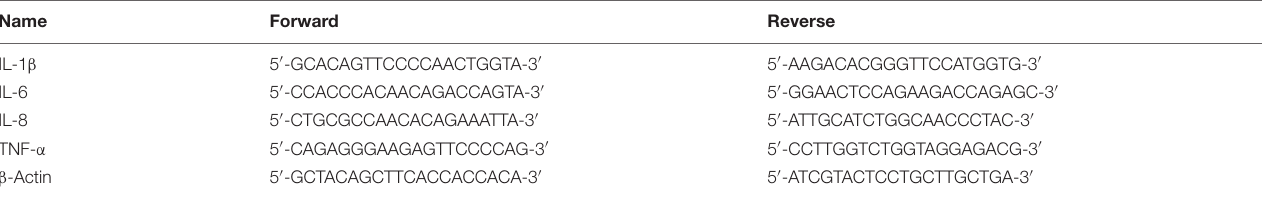
TABLE 1 | Primer sequences of IL-1 α , IL-1 β , IL-6, IL-8, TNF- α and β